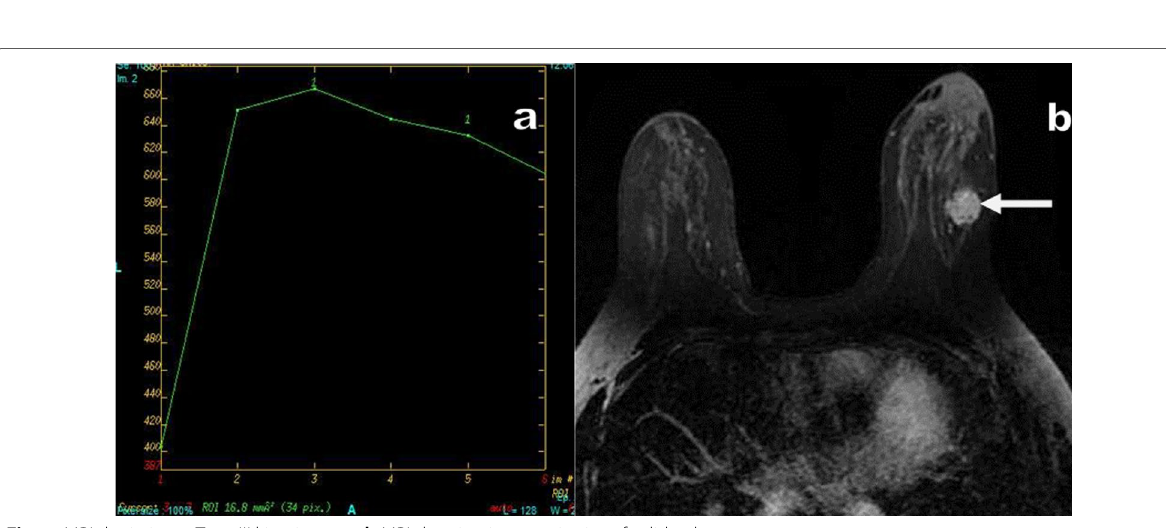
tense on T1W and hyperintense on T2W. Presence of